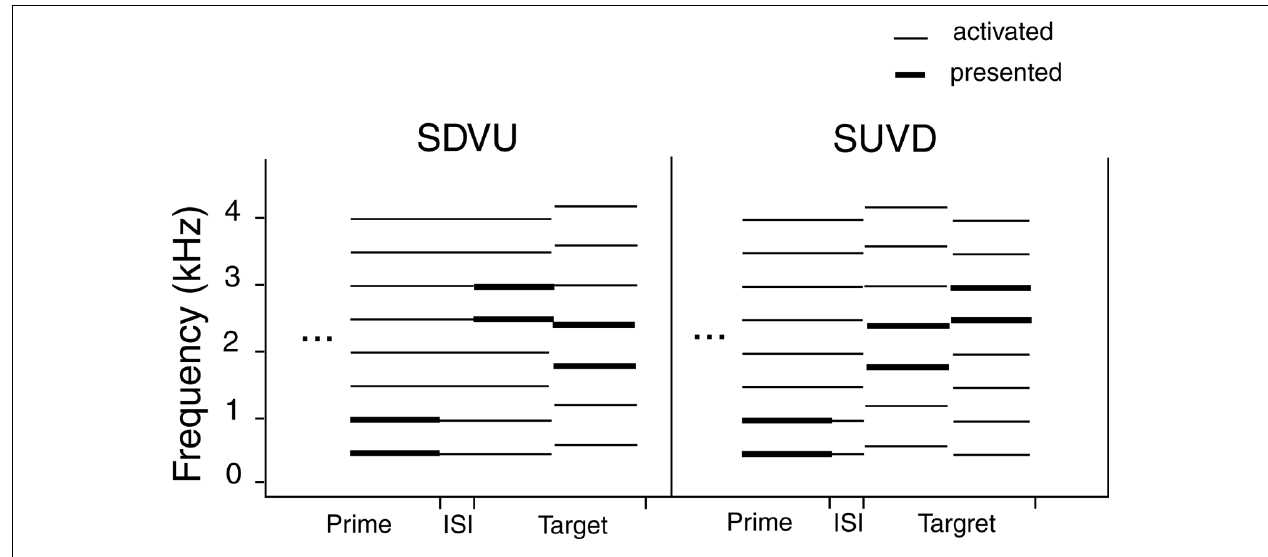
FIGURE 5 | Relationship between harmonic templates activated by the stimuli as a function of target type (SDVU = spectral down – virtual up; SUVD = spectral up – virtual down). Thick lines denote presented frequencies and the thin ones the frequencies that were activated by the stimuli.